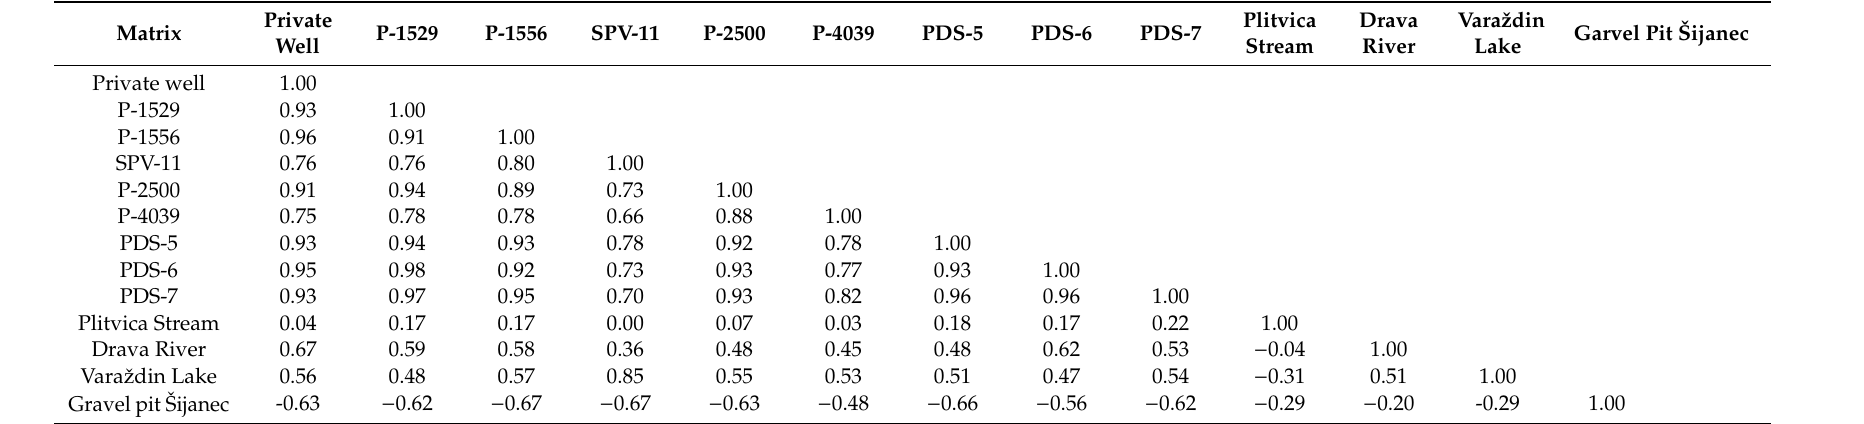
Table 9. Correlation matrix between ground and surface waters for δ 18 O ( o / oo )